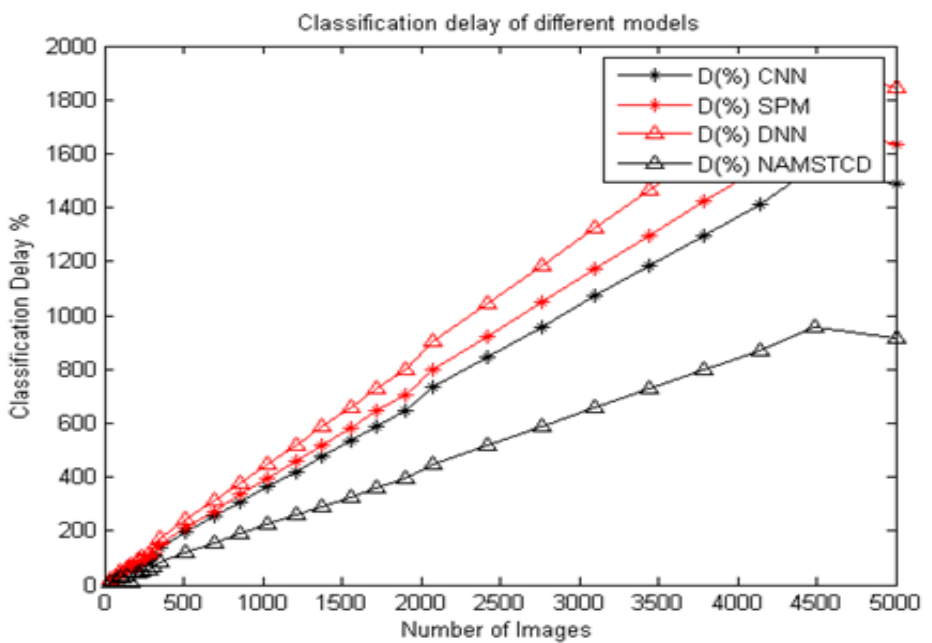
Figure 9. Computational delay of di ff erent